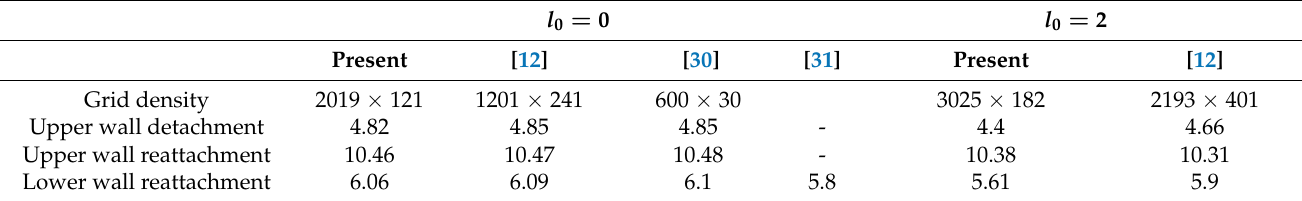
Table 1. Position of the upper wall detachment and reattachment and lower wall recirculation length for the backward facing step under steady, parabolic flow with Reynolds number 800 and without